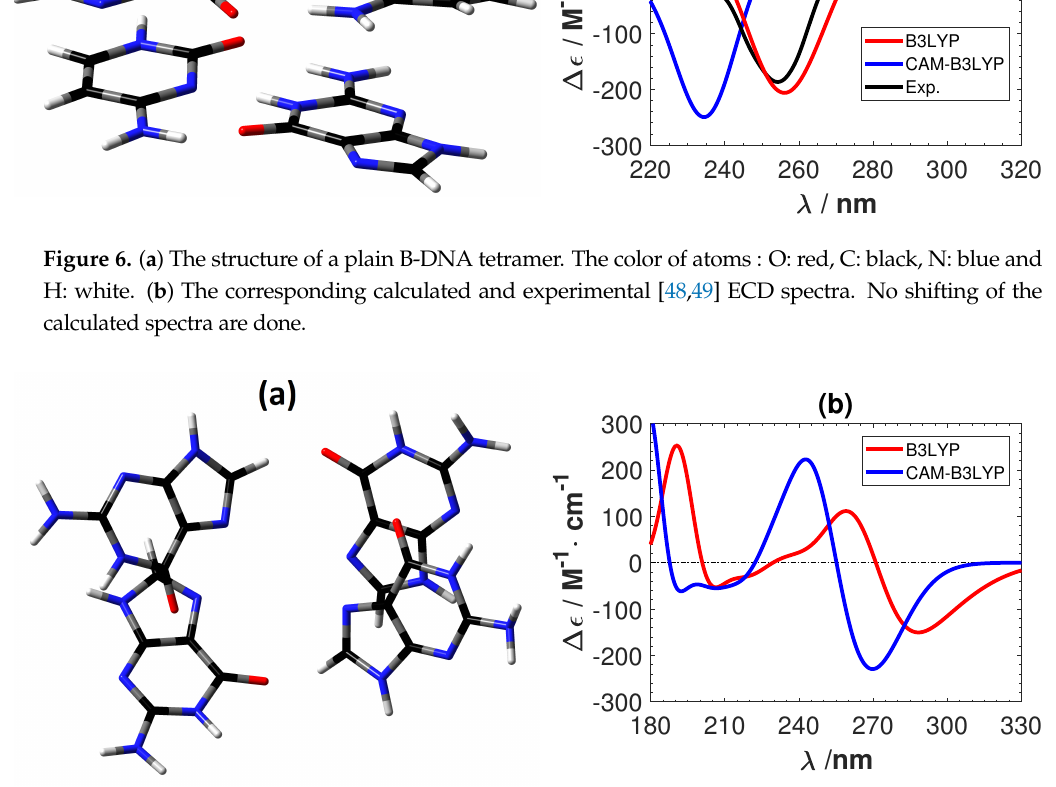
Figure 7. ( a ) The structure of a plain guanine tetramer. The color of atoms : O: red, C: black, N: blue and H: white. ( b ) The corresponding calculated ECD spectra. No shifting of the calculated spectra are